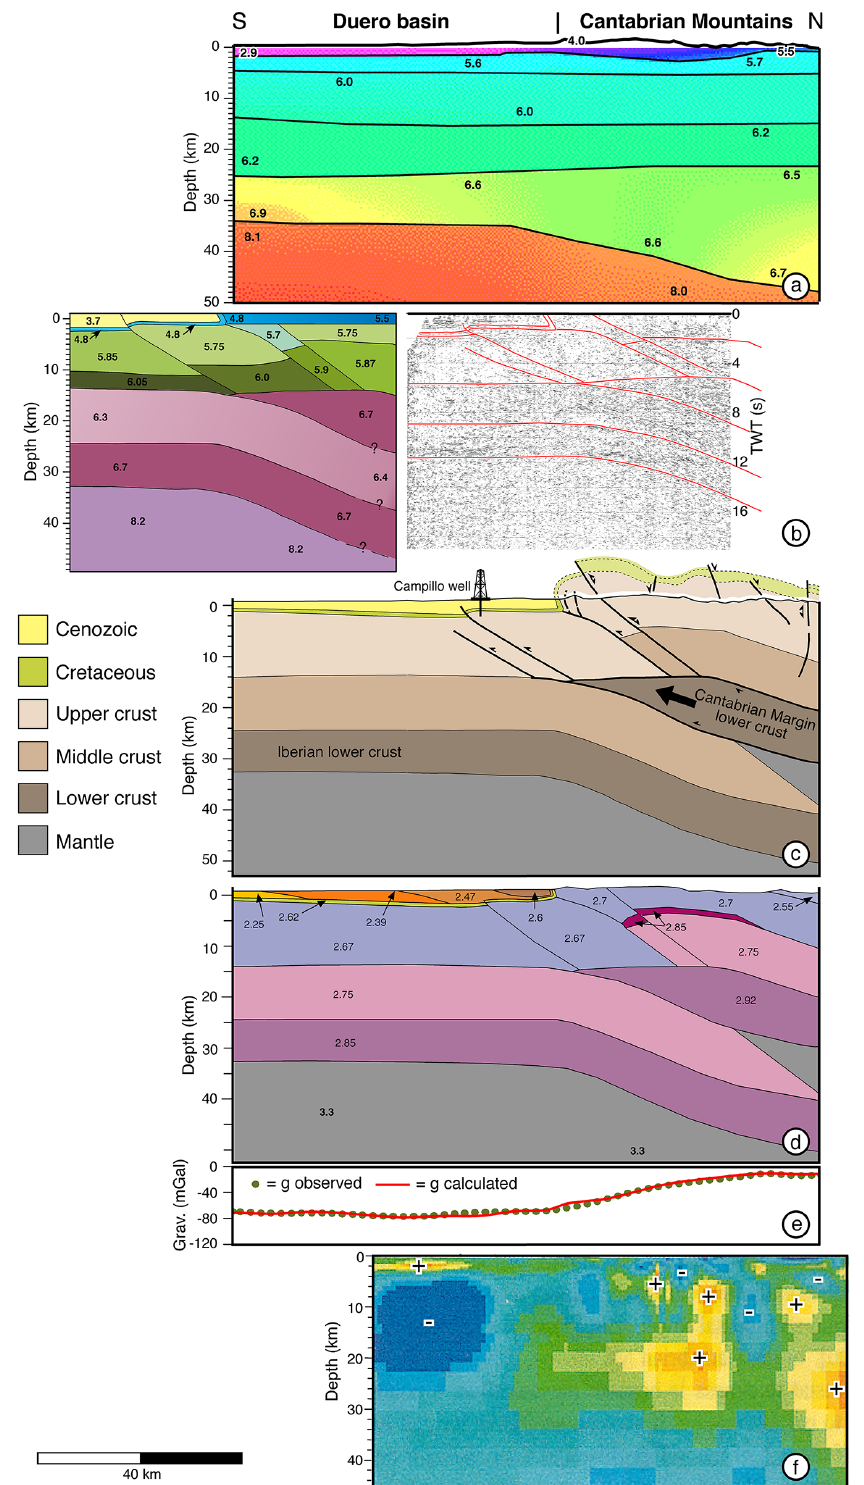
Figure 9. (a) Refraction velocity model parallel to ESCIN-2 (Pulgar et al., 1996; Fernández-Viejo, 1997; Gallart et al., 1995). (b) Velocity– depth model of ESCIN-2 obtained by forward seismic modelling of interphases shown in red in the interpreted deep seismic section. (c) Ge- ological cross section of the area that synthesizes all information available. (d, e) Two-dimensional gravity model, observed and calculated gravity anomaly of the studied area (Gallastegui, 2000). (f) Two-dimensional electrical resistivity model and location of resistivity highs and lows (adapted from Pous et al.,